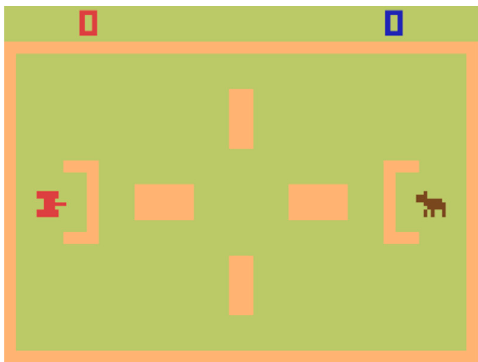
Figure 11. The player shares the battlefield with a harmless donkey.